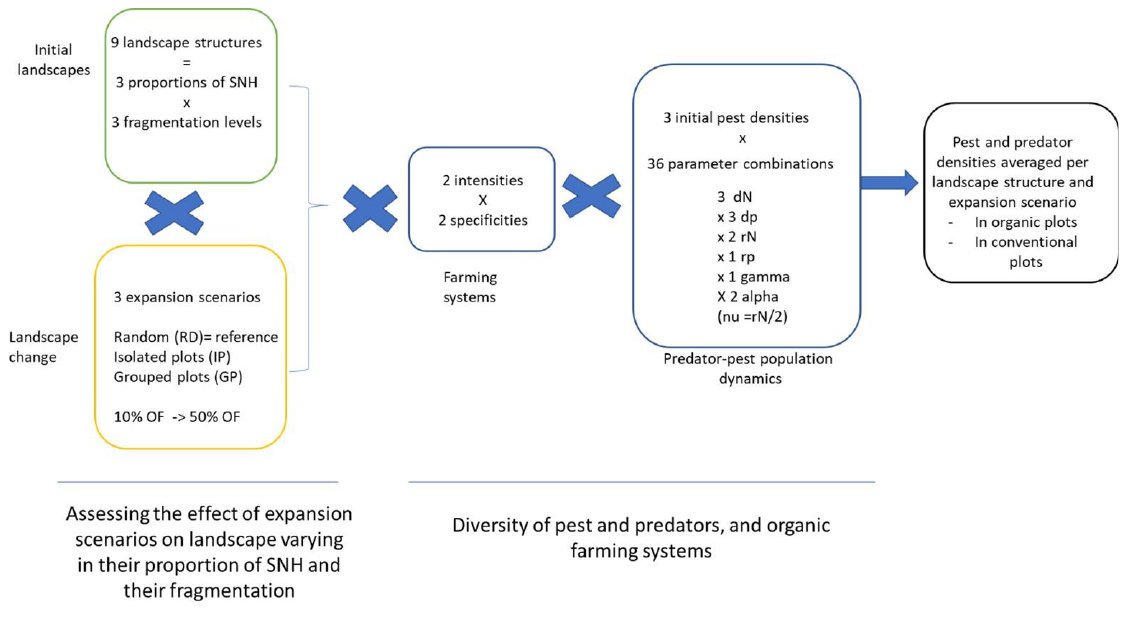
Figure 1 - The simulation design combines three spatial scenarios of organic farming expansion (Random versus IP or GP) in nine landscape contexts (3 proportions of seminatural habitats (SNH) x 3 fragmentation levels) for various predator-pest population dynamics (36 pest biology parameter combinations and 4 pest management types in the organic farming system). The green box corresponds to the landscape model, the blue box to the population dynamic model and the orange box to the land change